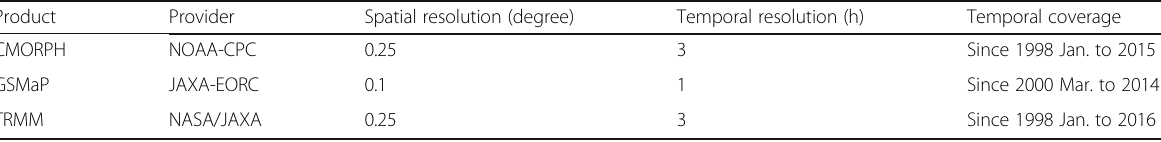
Table 1 Summary of the three SPDs used in this study Product